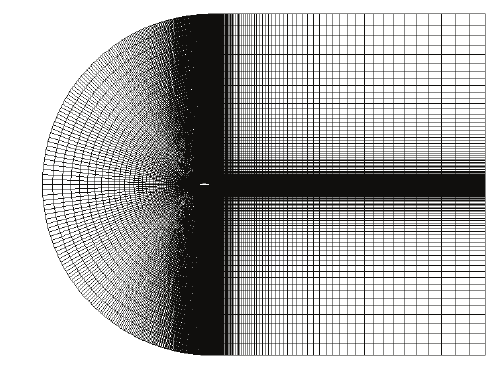
Figure 1: A global view of the mesh.